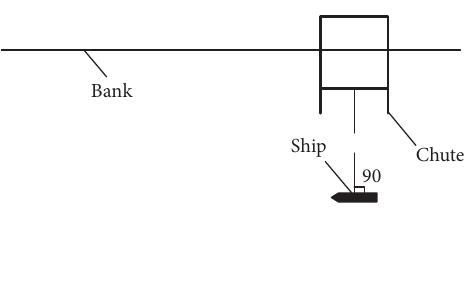
Figure 11: Schematic of the landslide surge and ship